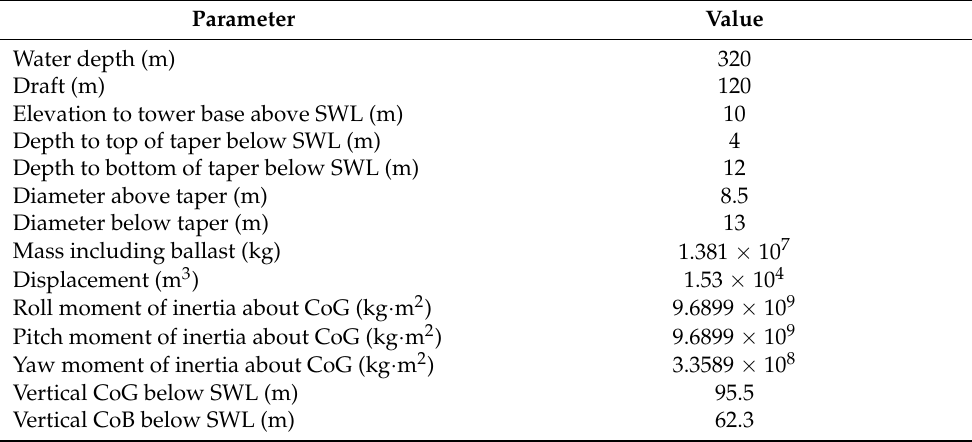
Table 3. Parameters of the spar platform.